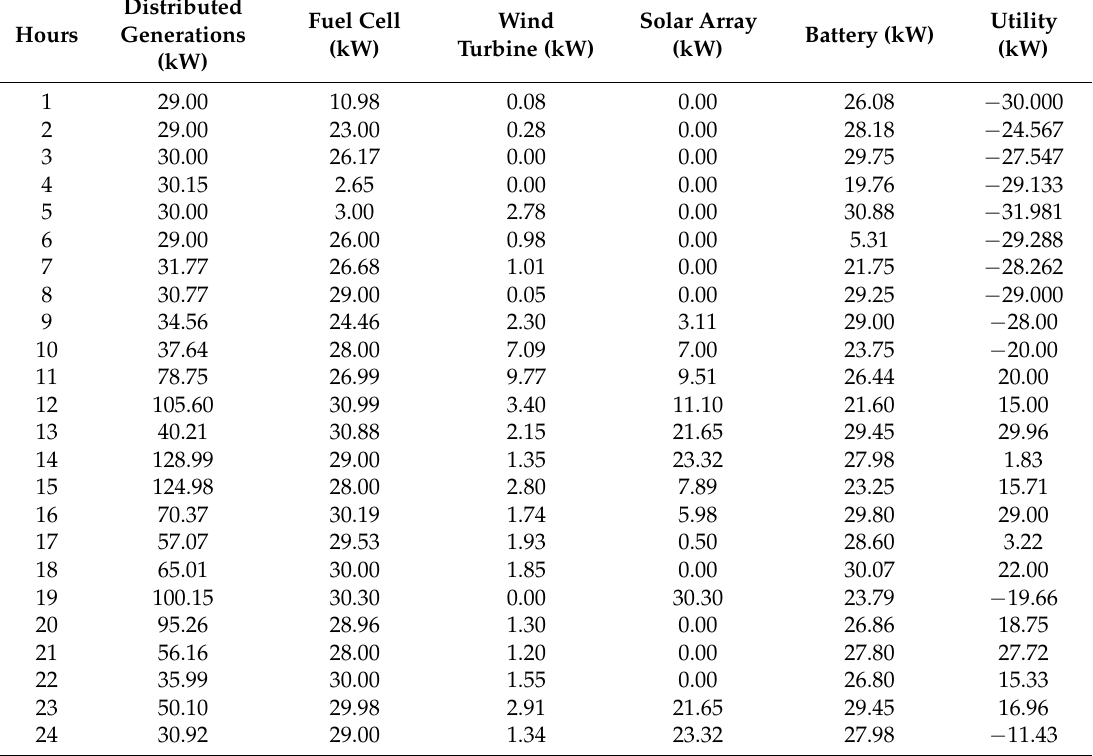
Table 3. Carbon emission optimization of different energy generating units with